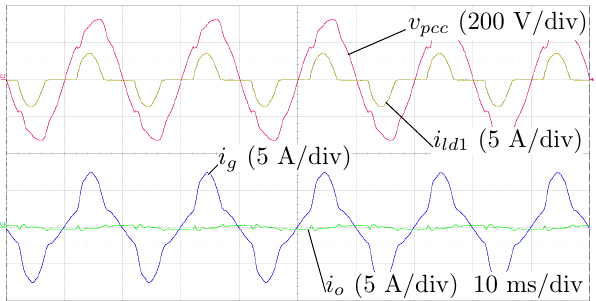
Figure 8. Experimental waveforms when the converter operation is disabled; from the top to the bottom are the pcc voltage v pcc , the non-linear load current i ld 1 , the grid current i g and the converter output current i o